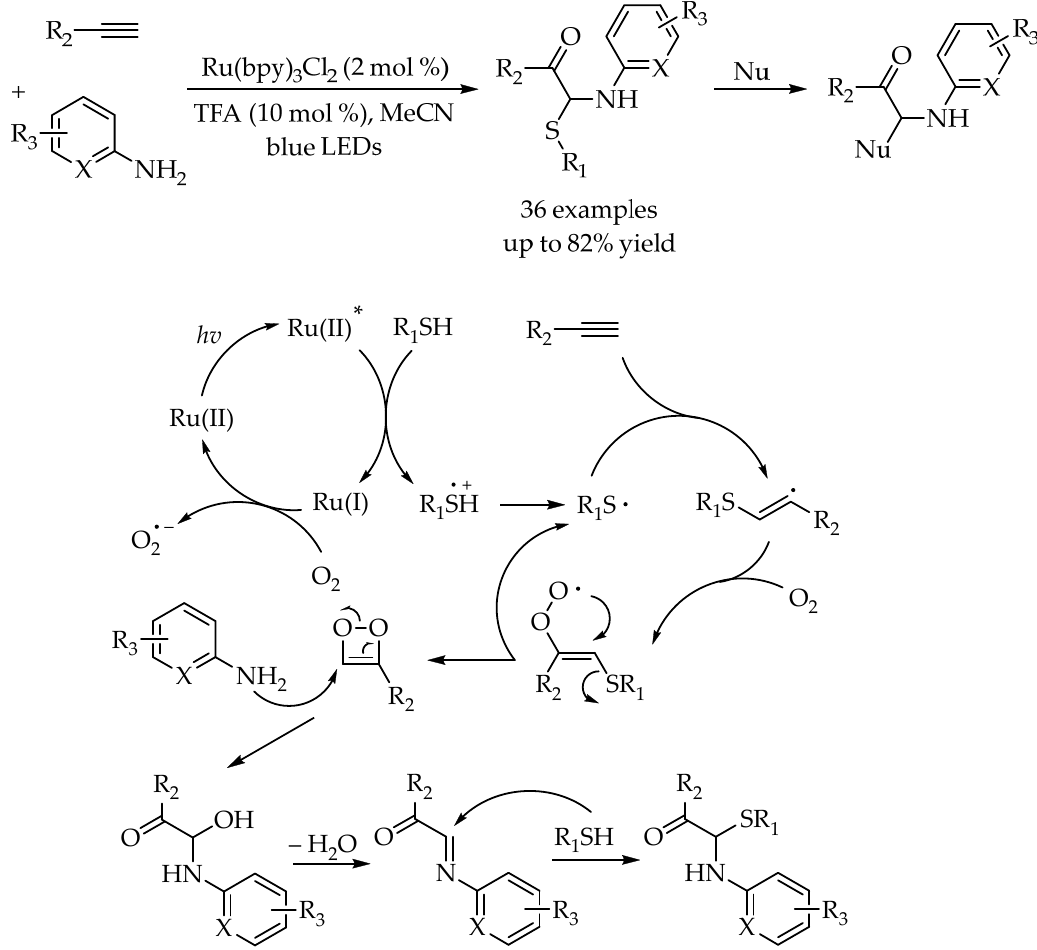
Scheme 15. Visible ‐ light ‐ photocatalyzed gem ‐ difunctionalization of alkynes for the synthesis of α , α ‐ aminothio ‐ substituted carbonyl compounds.